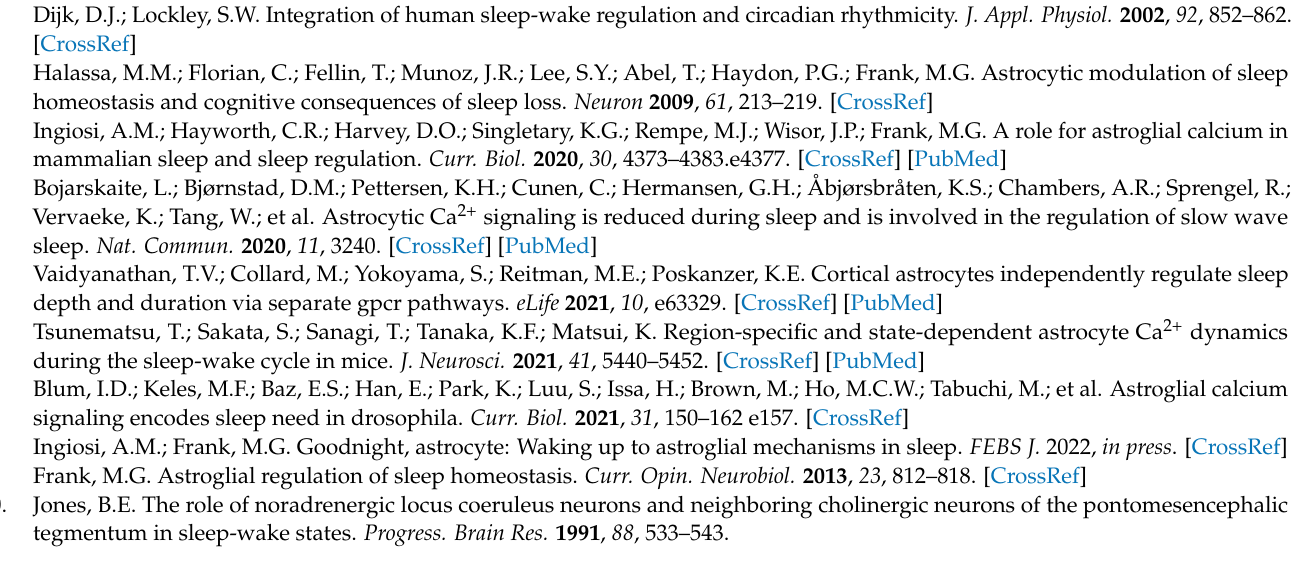
AR cKO, Figure S2: Assessment of Astroglial β 2-AR cKO on Electroencephalographic Activity and Physiology, Figure S3: Arousal State-specific Electroencephalography (EEG) and Electromyography (EMG) from a WT Mouse and a cKO